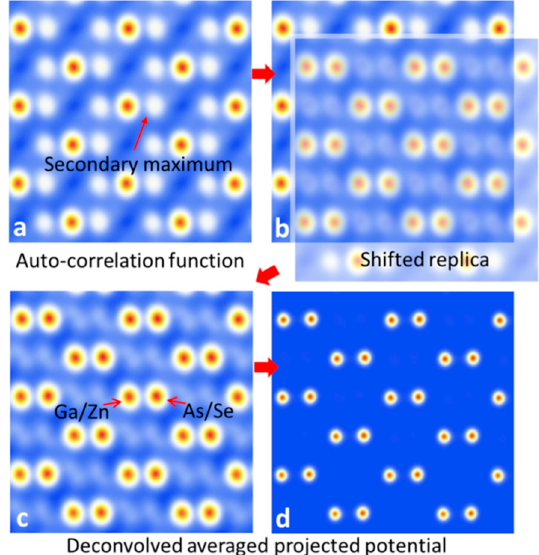
Figure 8. Deconvolution of the auto-correlation function C ( r ): ( a ) C ( r ) obtained by the inverse Fourier transform (FT) of the rescaled diffraction pattern for the ZnSe/GaAs heterostructure, oriented in a [110] zone axis. ( b ) shifted replica of the auto-correlation function C ( r - r M ) centered on a secondary maximum r M . ( c ) product of C ( r ) and C ( r - r M ). ( d ) projected potential obtained deconvolving the contribution to the column width due to the auto-correlation.